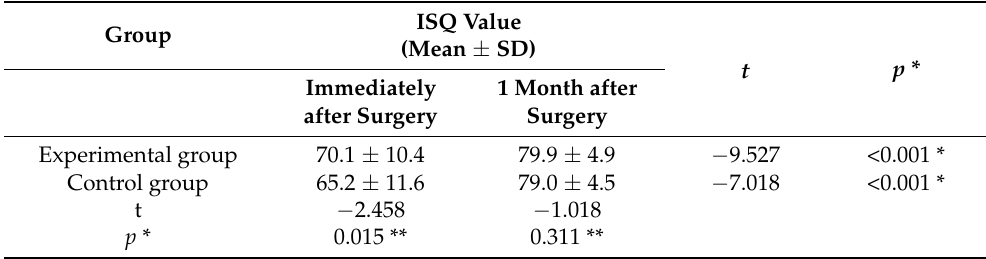
Table 4. Comparison of the implant stability quotient (ISQ) values for different implant handpiece systems. ISQ Value Group (Mean ± SD) t p * Immediately 1 Month after after Surgery Surgery Experimental group